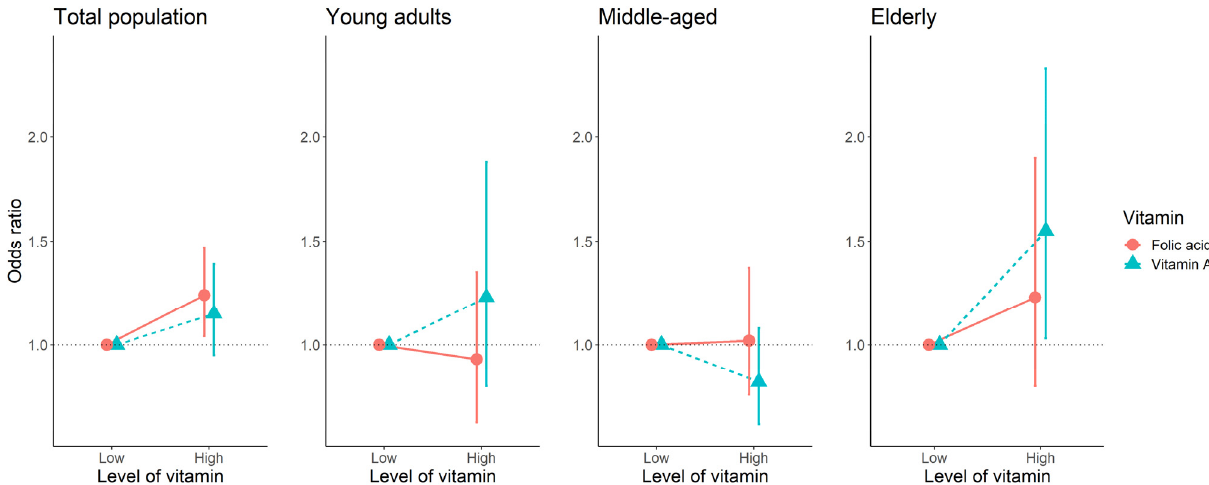
Figure 3. The association between binary variables of vitamin A and folic acid, and EQ-5D using logistic regression. Abbreviations: EQ-5D, EuroQol Five-Dimension Questionnaire; OR, odds ratio; Higher EQ-5D: ≥ 91.3 in total participant, young adult and middle-aged groups; ≥ 77.4 in elderly.